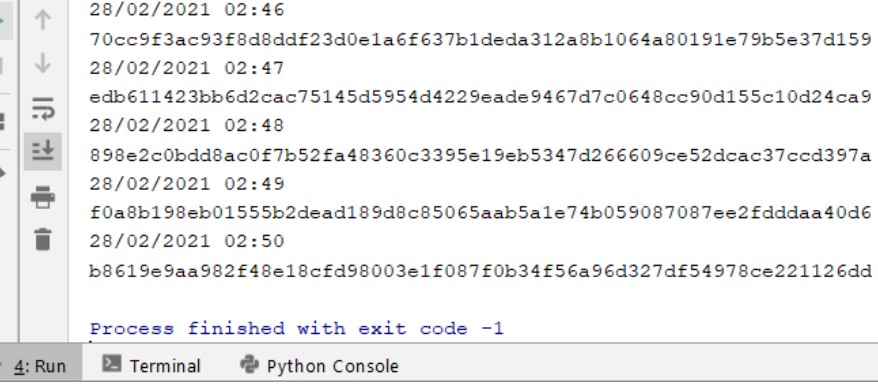
Figure 3. Hash values of content associated with different requests for a “dynamic”